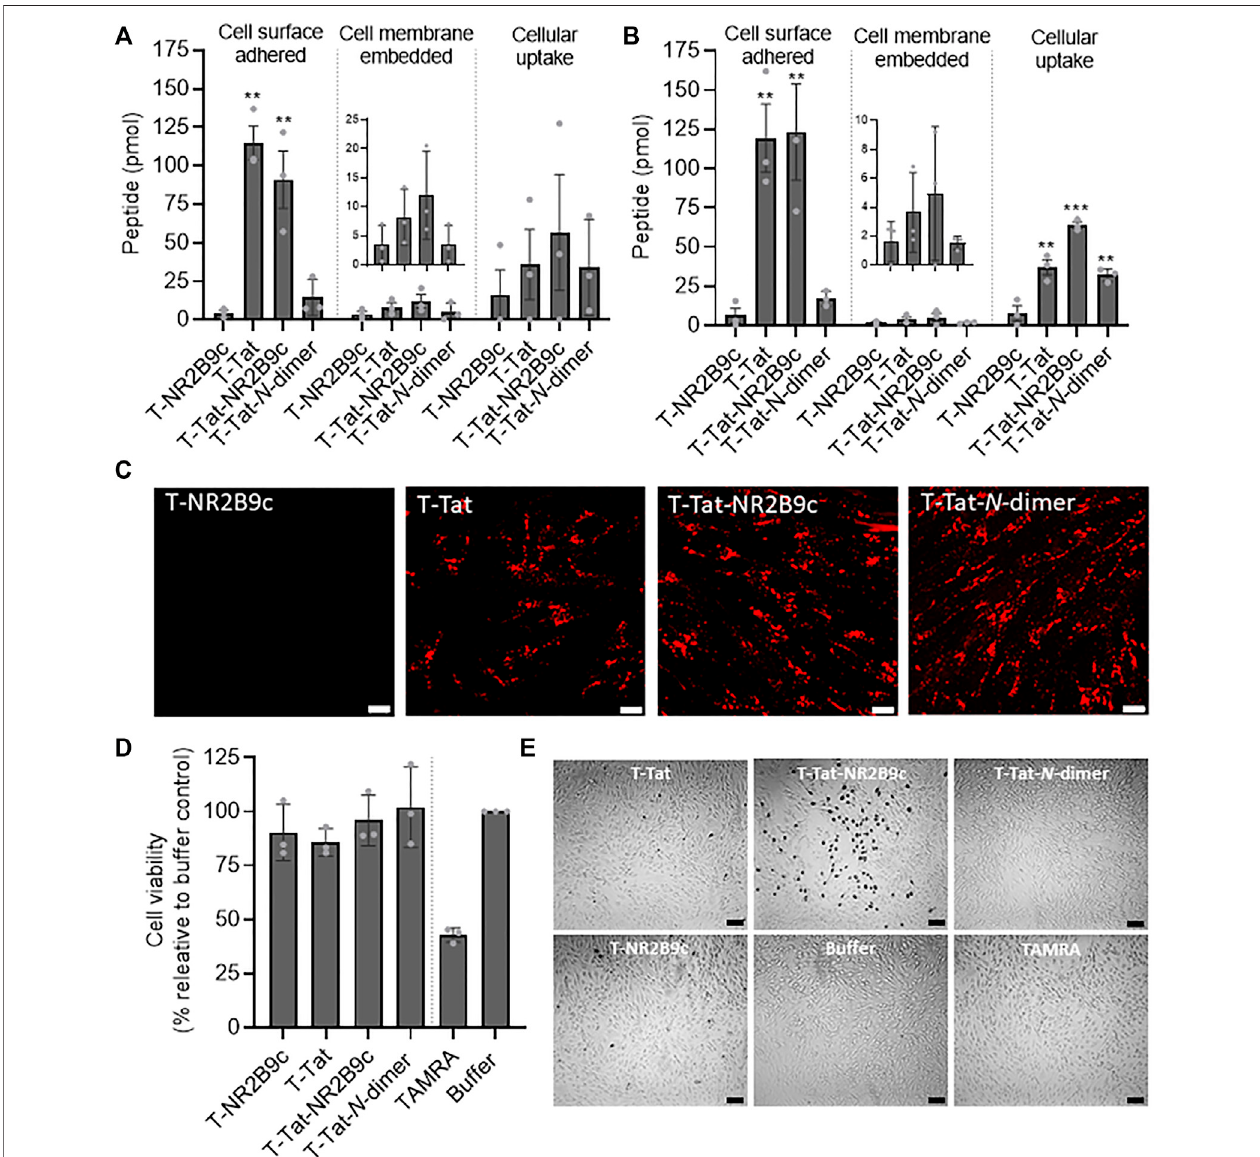
FIGURE 2 | Peptide cellular distribution, live cell uptake, and effects on cellular viability. Peptide cell surface adherence, cell membrane embedding, or cellular uptake in (A) the mouse brain capillary bEND3 cell line and (B) the human-induced pluripotent stem cell line BIONi010-C after incubation with 5 μ M T-NR2B9c, T-Tat, T-Tat-NR2B9c, or T-Tat- N -dimer for 1 h at 37 ° C. Mean ± SD ( N = 3, n = 3); **: p < 0.01 and ***: p < 0.001 compared to T-NR2B9c (one-way ANOVA with Dunnett ’ s multiplecomparisonstest). (C) PeptideuptakeintolivebEND3cellsafterincubationwith50 μ MT-NR2B9c,T-Tat,T-Tat-NR2B9c,orT-Tat- N -dimerfor1 hat37 ° C evaluated via TAMRA fl uorescence using confocal laser-scanning microscopy. Single xy sections, scale bar: 10 µm. (D) bEND3 cell viability after incubation with 50 μ M T-NR2B9c, T-Tat, T-Tat-NR2B9c, T-Tat- N -dimer, or TAMRA depicted as percentage relative buffer control. Mean ± SD ( N = 3, n = 3). (E) Trypan Blue uptake into bEND3 cells after incubation with 50 μ M T-NR2B9c, T-Tat, T-Tat-NR2B9c, T-Tat- N -dimer, or TAMRA imaged by bright fi eld microscopy. Scale bar: 50 µm.